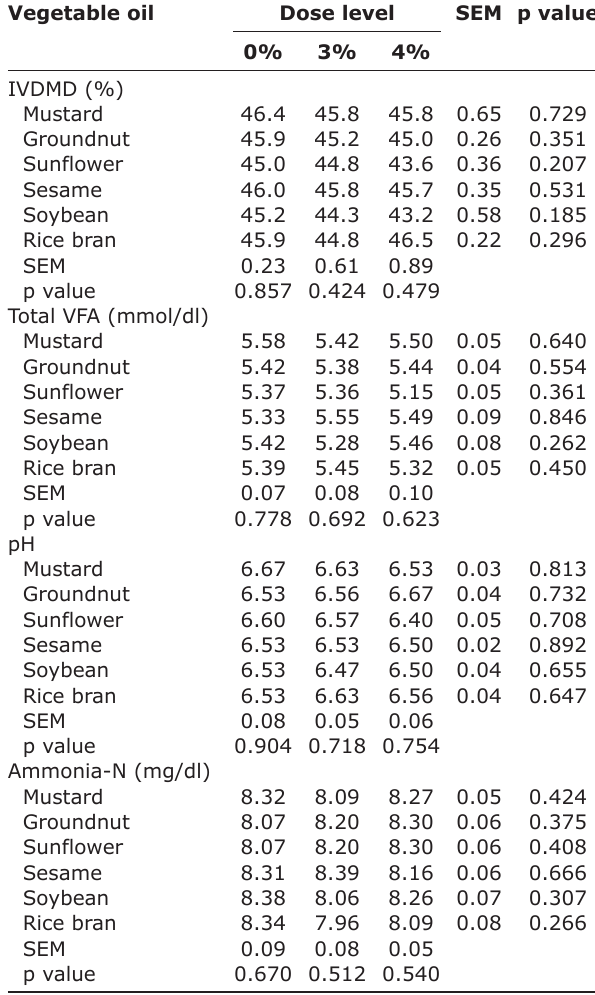
Table-2: Effects of vegetable oil supplementation on rumen fermentation in the rumen fluid after 24 h of